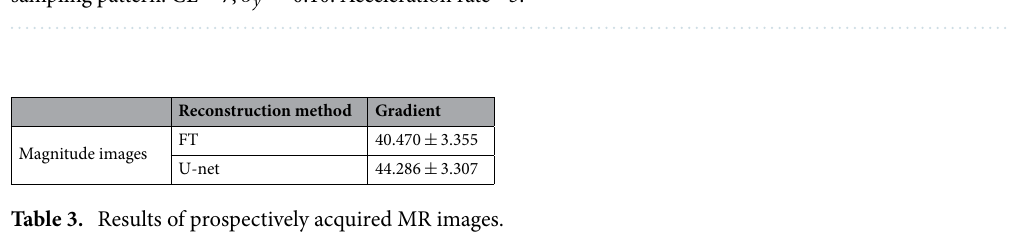
Figure 6. Reconstruction results of 3 different prospectively undersampled MR data with the Gaussian sampling pattern: CL = 7, σ y = 0.10 . Acceleration rate = 5.